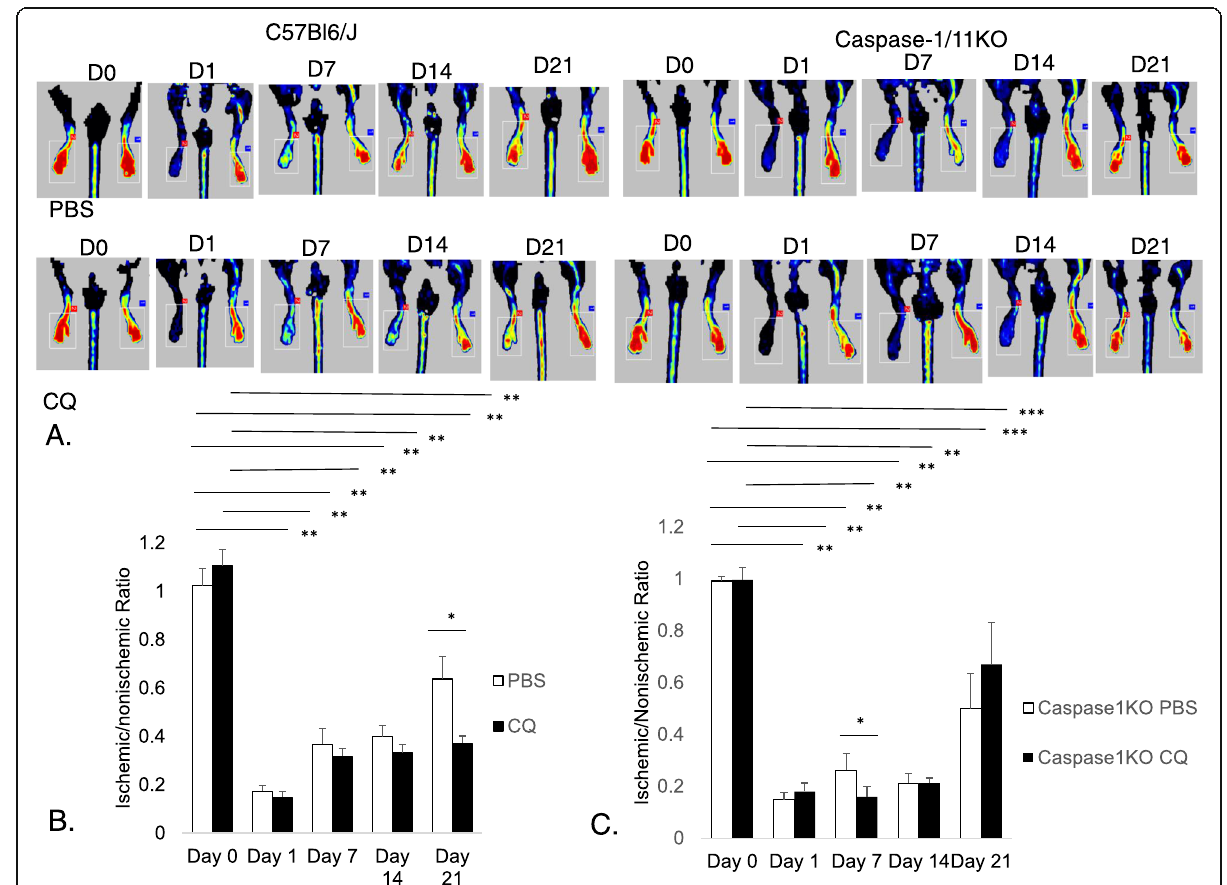
Fig. 4 CQ reduces hindlimb perfusion recovery after femoral artery ligation (FAL). a Laser Doppler Perfusion Imaging (LDPI) of C57Bl6/J (WT) and caspase-1/11KO treated with either CQ or PBS (control) over the course of the study. LDPI was performed just before ligation (Day 0), and 1, 7, 14 and 21 days after FAL on the right hindlimb (screen left on each image). Representative images shown. LDPI in each animal expressed as a ratio of perfusion in ischemic to the nonischemic limb in. b N = 7 WT mice/experimental group;* p < 0.01; ** p < 0.001, and in ( c ) * p < 0.01; * p < 0.0001; *** p < 0.05 N = 4 KO mice/experimental